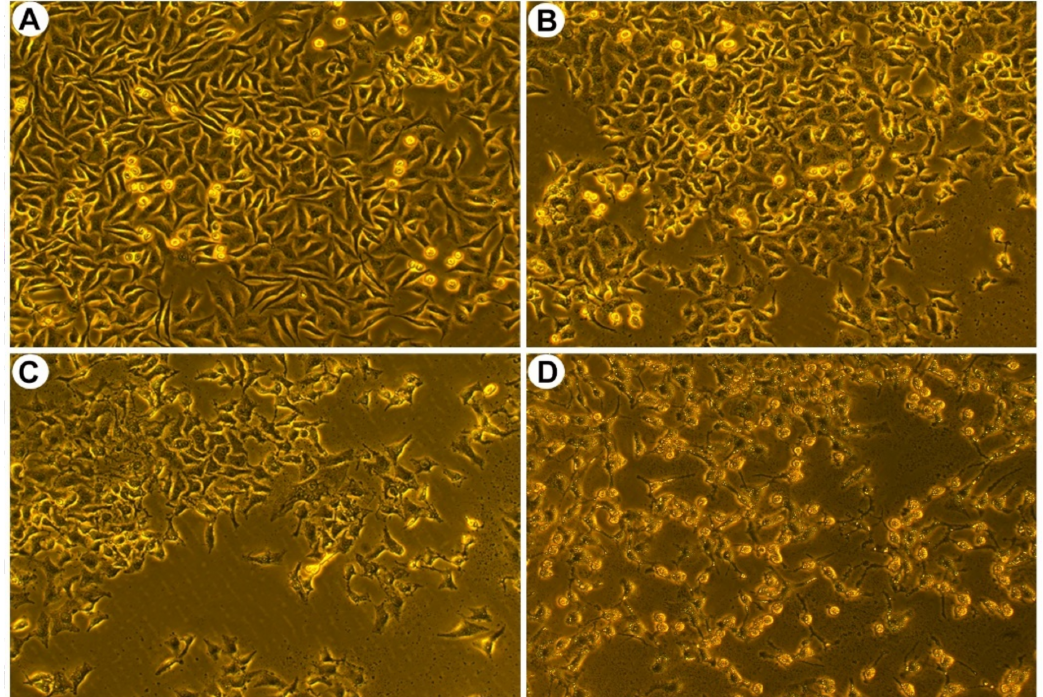
Figure 2. Morphological characteristics of SGC-7901 cells after treated with indicated concentrations of SPPH for 36 h. Morphological changes of SGC-7901 cells were observed after SPPH treated with different concentrations, ( A ) control; ( B ) 80 µ g/mL; ( C ) 160 µ g/mL; ( D ) 320 µ